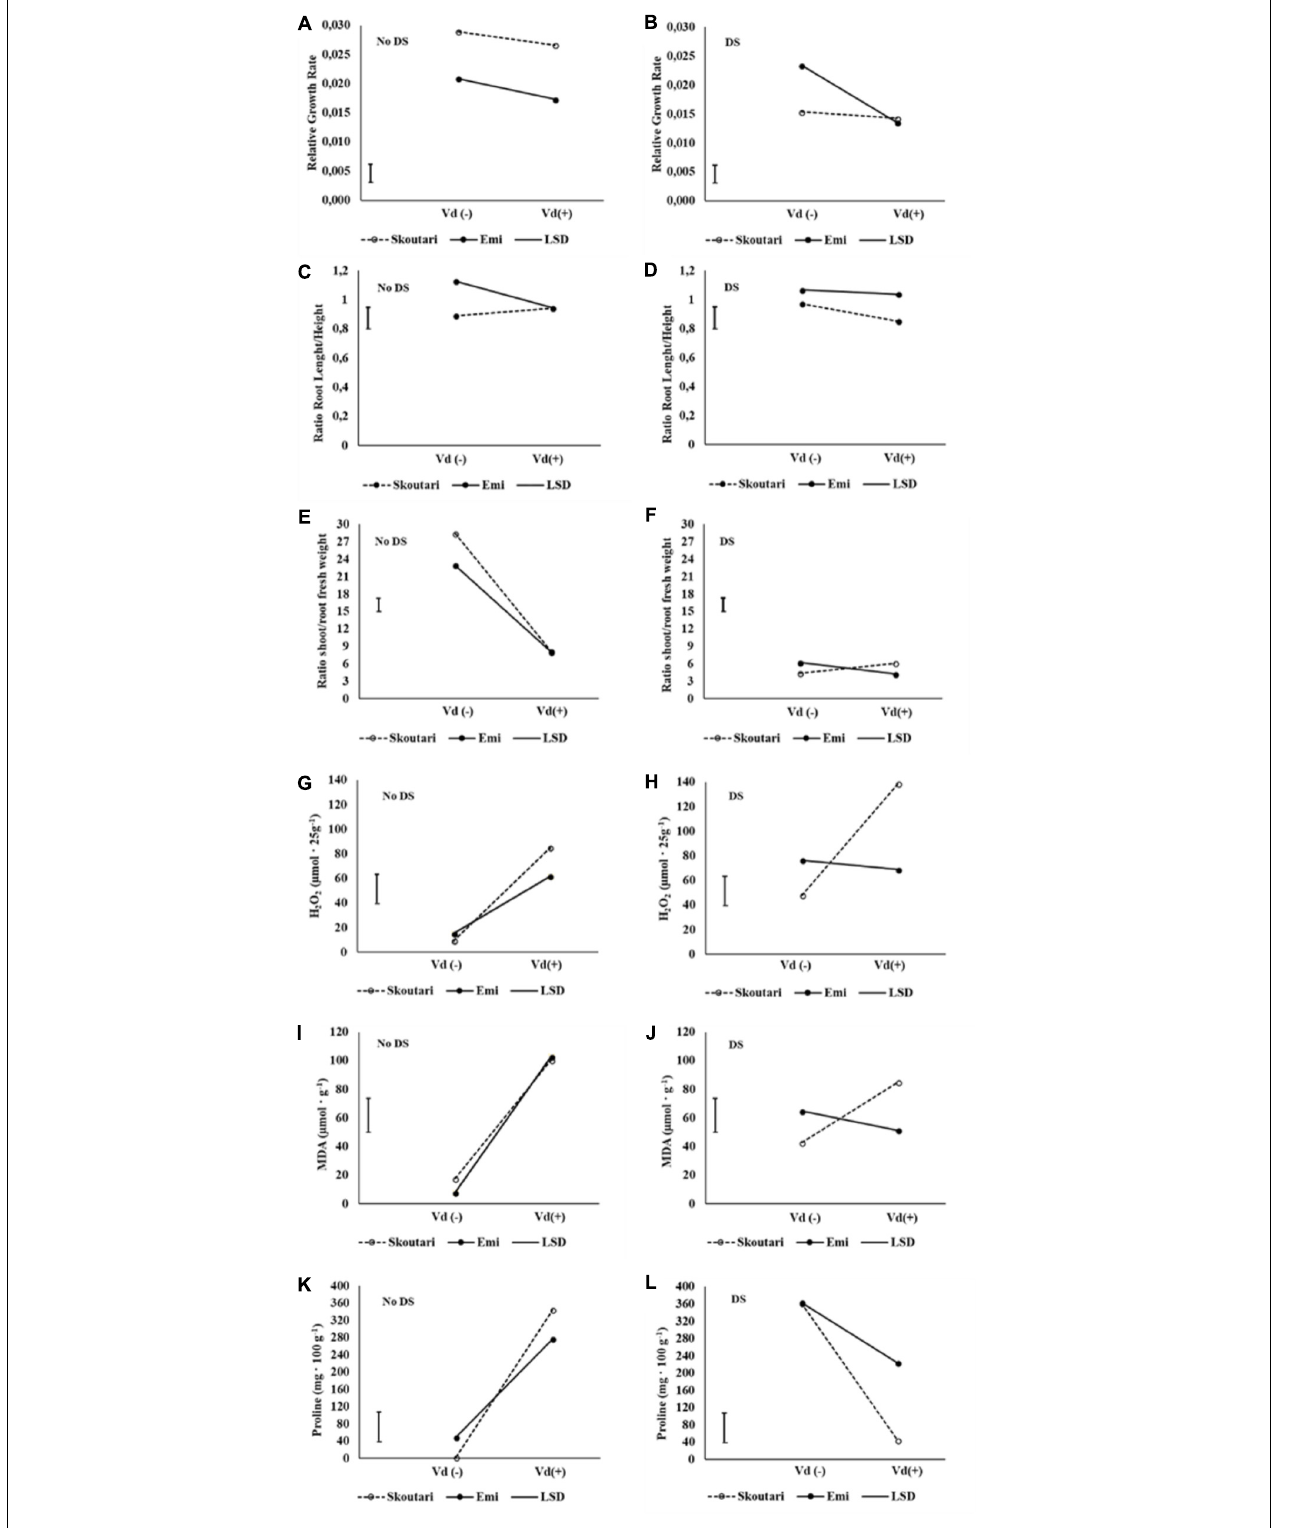
FIGURE 1 | Three-way interaction plots of RGR (A,B) , root to stem length ratio (C,D) , shoot to root fresh weight ratio (E,F) , H 2 O 2 (G,H) , MDA (I,J) and Proline (K,L) concentrations, on two eggplant cultivars (Skoutari and Emi), at V. dahliae infection and drought stress. Vd ( ± ): Verticillium dahliae , DS: drought stress.